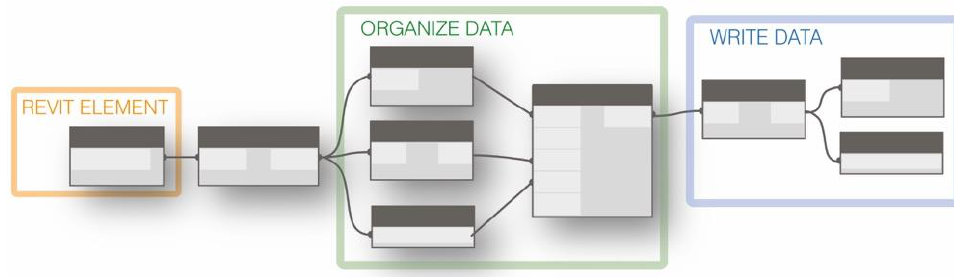
Figure 4. Dynamo structure of nodes.